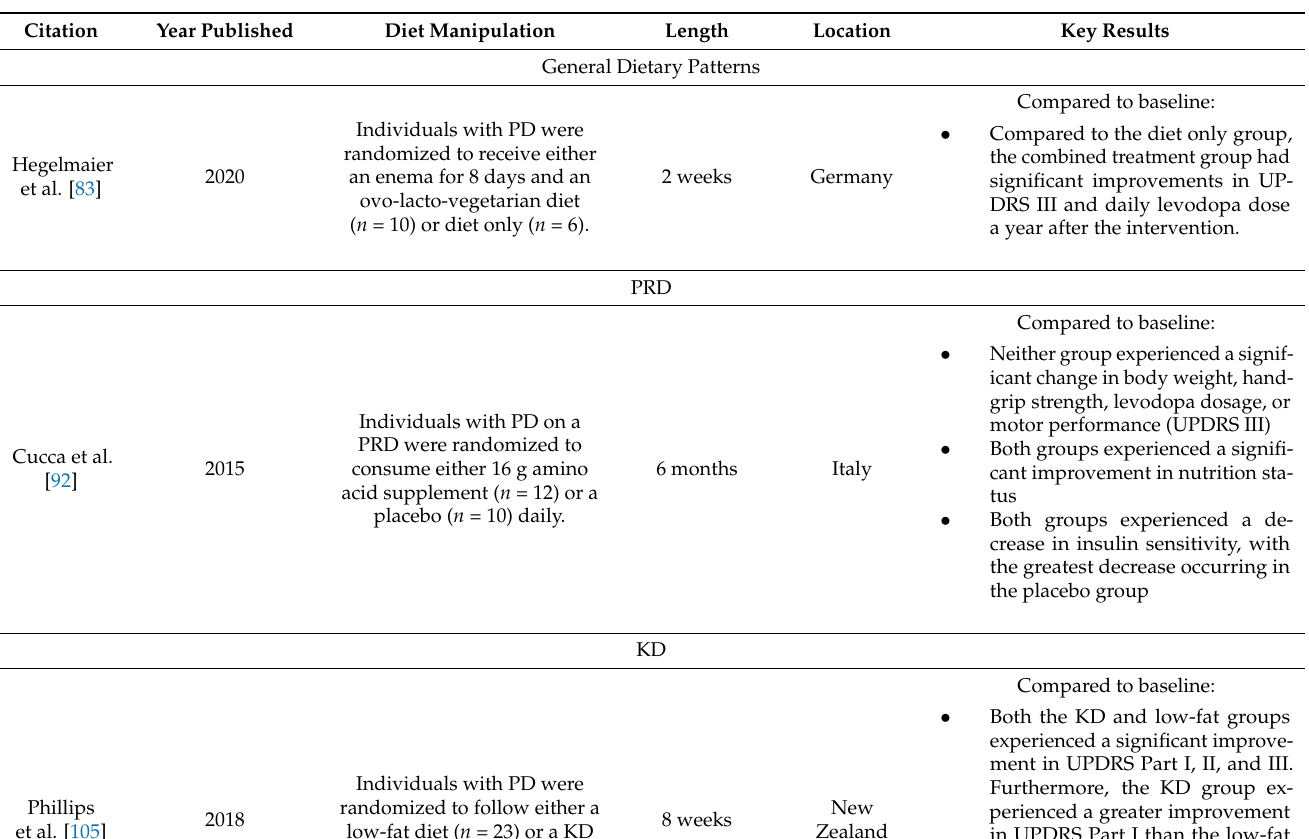
Table 2. Summary of Clinical Study Results on the Impact of Diet and Dietary Patterns on